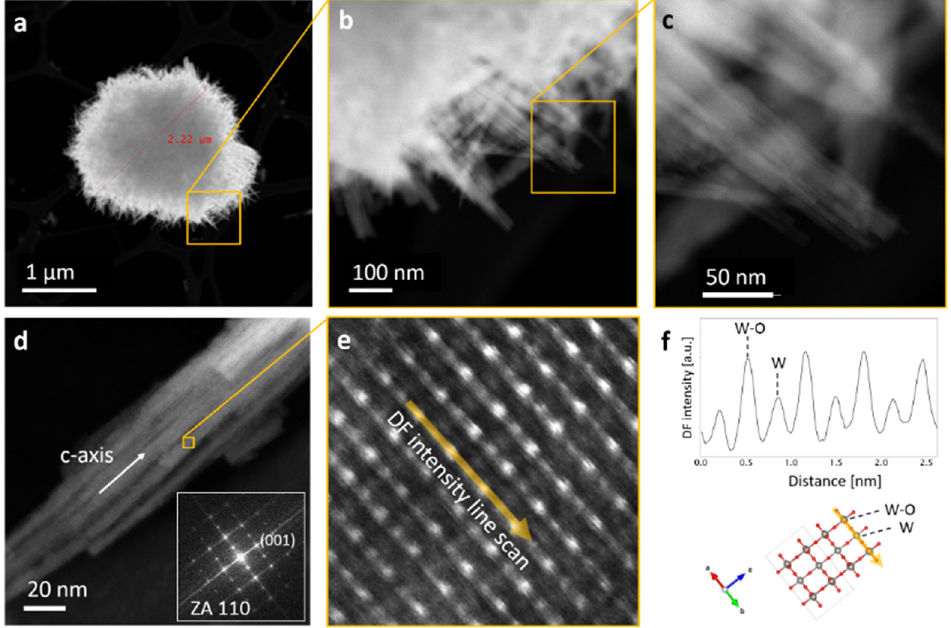
Figure 2. STEM Z-contrast micrographs of ( a – c ) a single urchin-like nanostructure at increasing magnification and ( d ) a single nanorod, composed of aligned nanoneedles; ( e ) enlarged view of the atomic lattice of a WO 3 nanoneedle ( f ) DF intensity line scan of ( e ) and 3D atomic model of the WO 3 hexagonal unit cell. Inset: FFT of ( d ) .